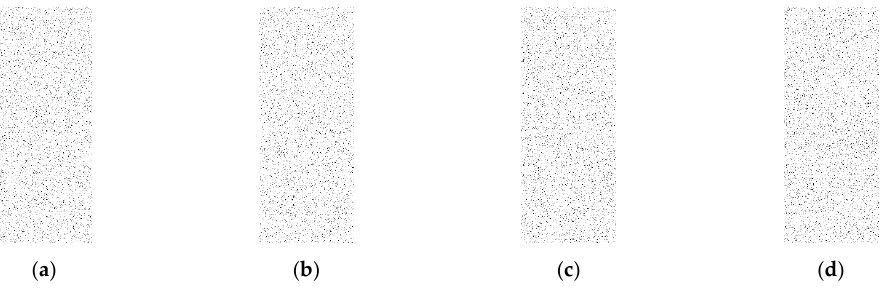
Figure 8. Rate is 0.05, ( a ) is the completely random scenarios; ( b ) is DUD scenarios; ( c ) is DAD